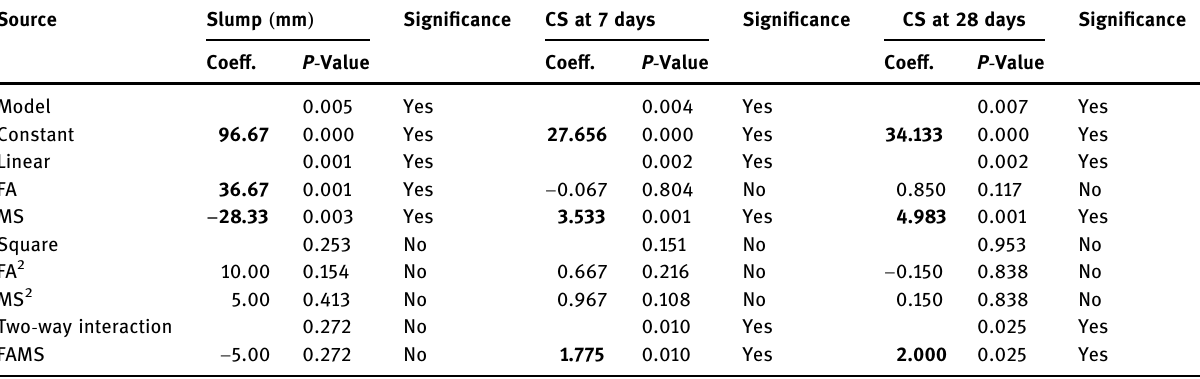
Table 5: ANOVA results